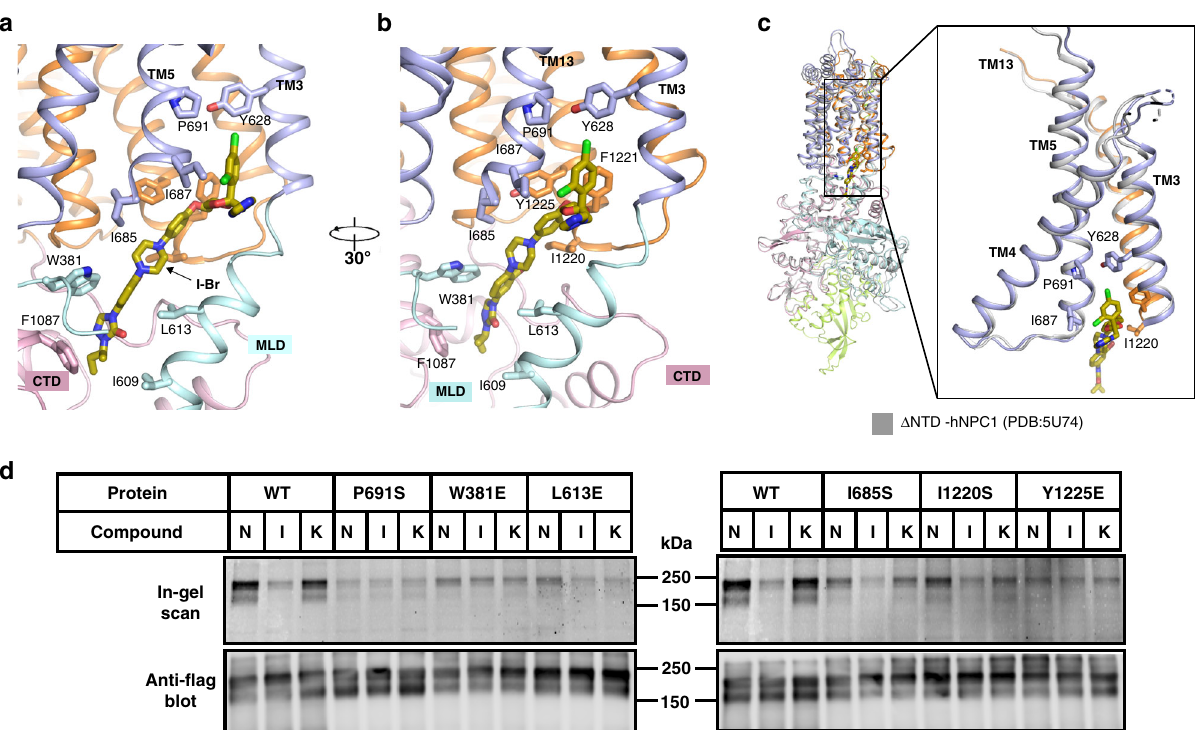
Fig. 4 I-Br binds to the hydrophobic cavity of NPC1. a , b Details of I-Br binding to NPC1. The residues involved in the interaction are shown in sticks; the secondary structures are labeled. c Structural comparison of I-Br-bound NPC1 to Δ NTD-NPC1 (gray). d Cross-linking of P-X to NPC1 and mutants in intact cells. Compound: none (N), itraconazole (I) and ketoconazole (K). P-X can easily cross-link to WT NPC1, and itraconazole inhibits this reaction but ketoconazole does not. All the mutants have a decreased ability to cross-link to P-X. Source data are provided as a Source Data fi